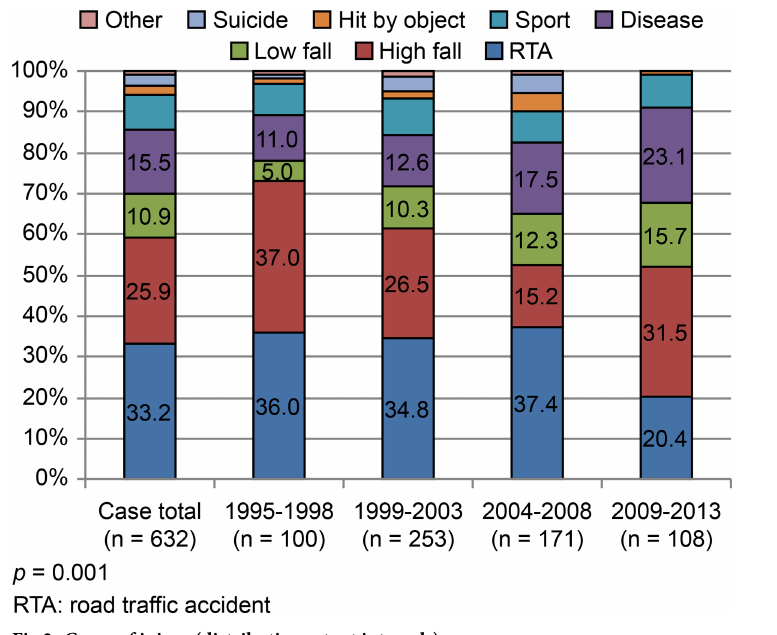
Fig 2. Cause of injury (distributions at set